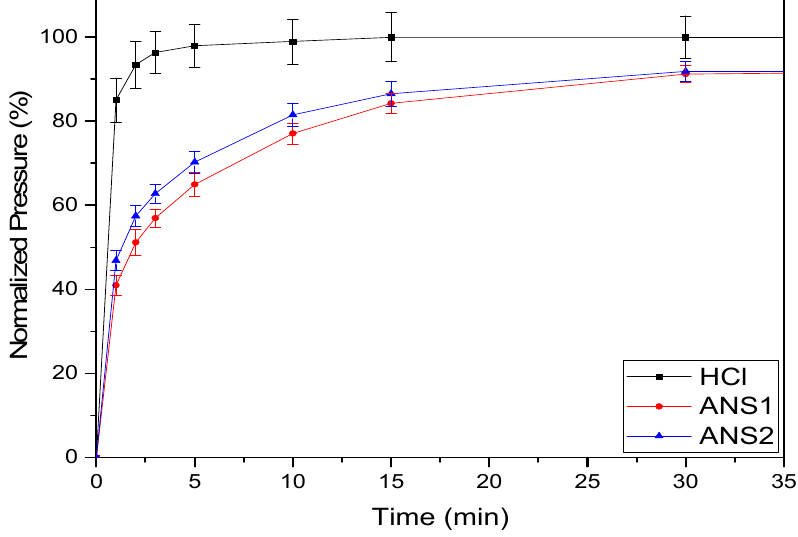
Figure 12. Consumption of calcium carbonate with time.